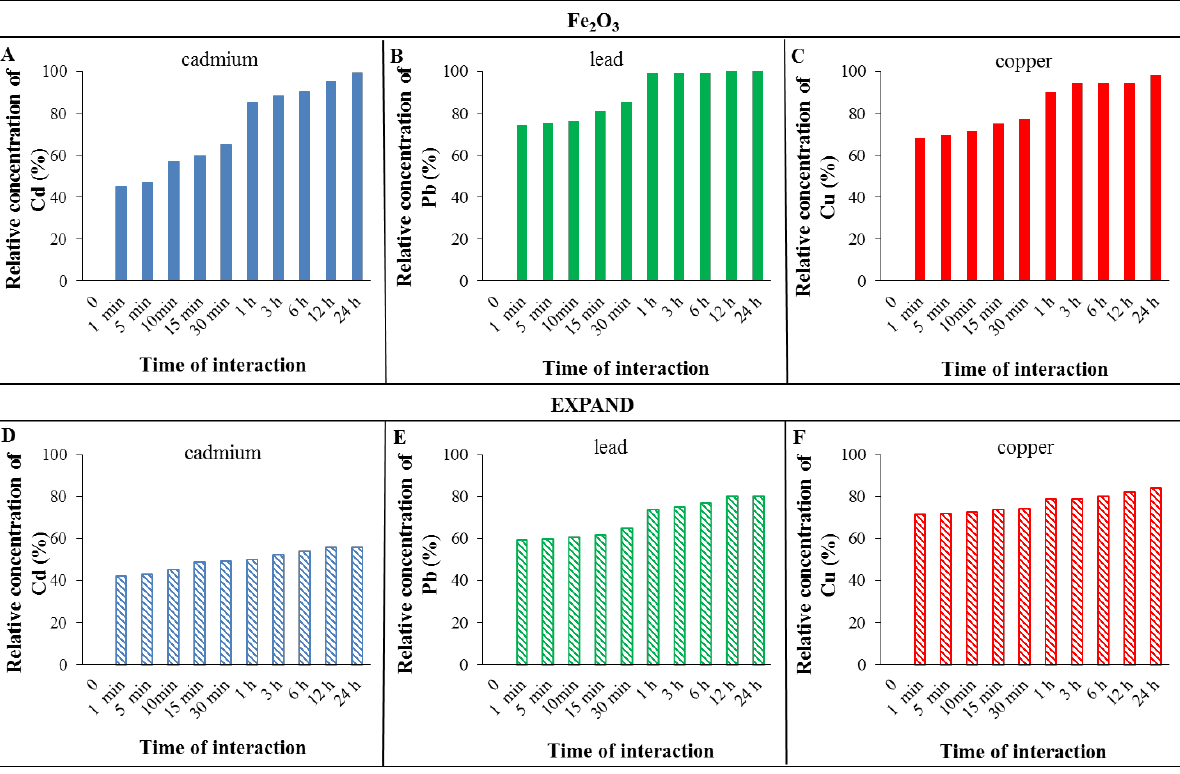
O ; ( D , E , F ) for expanded carbon. All values were 2 3